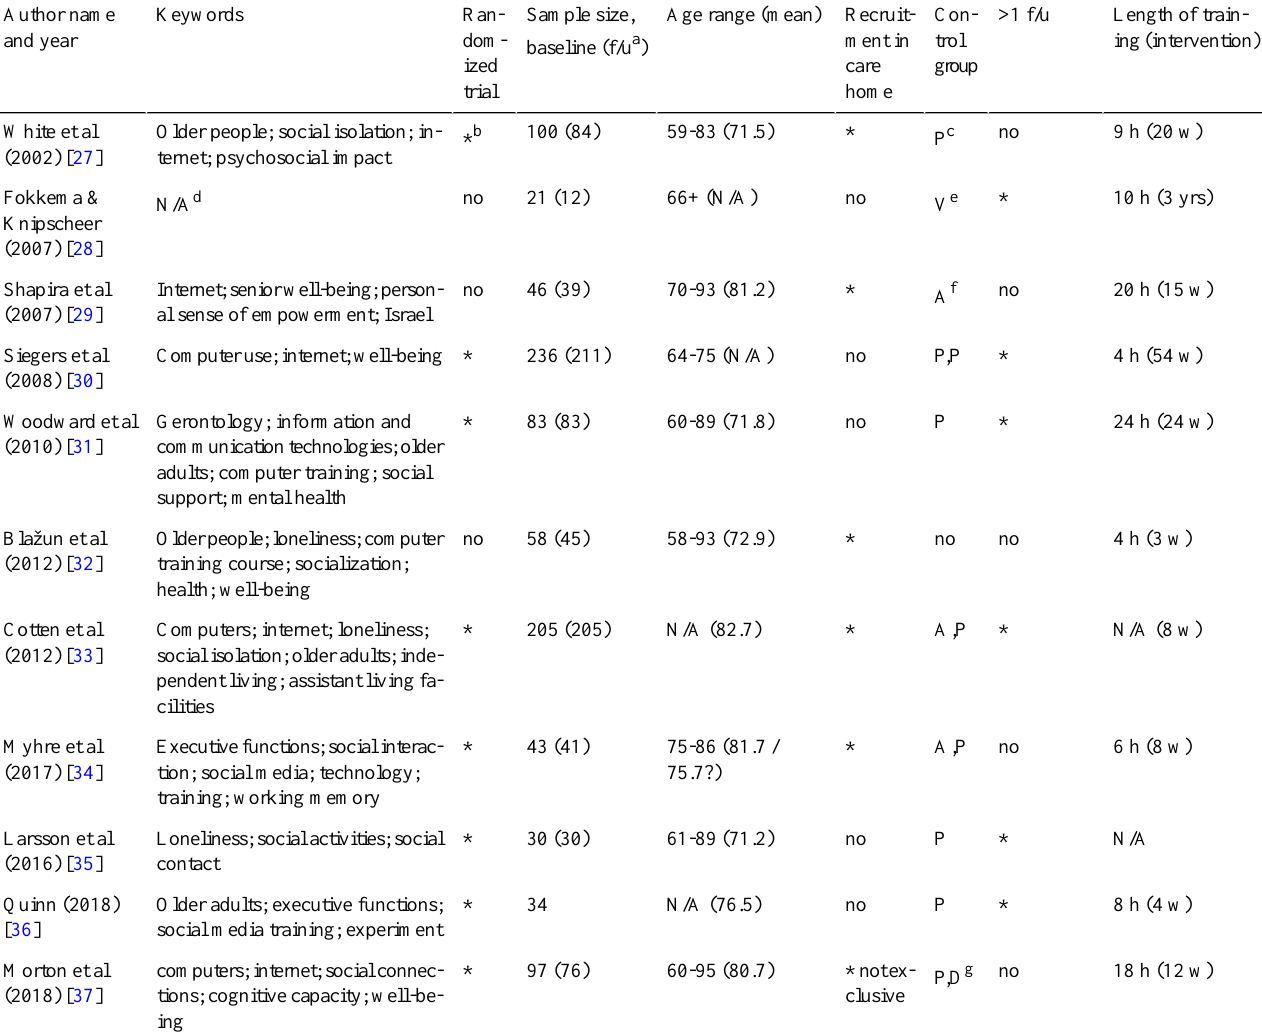
Table 2. Keywords and protocol characteristics.